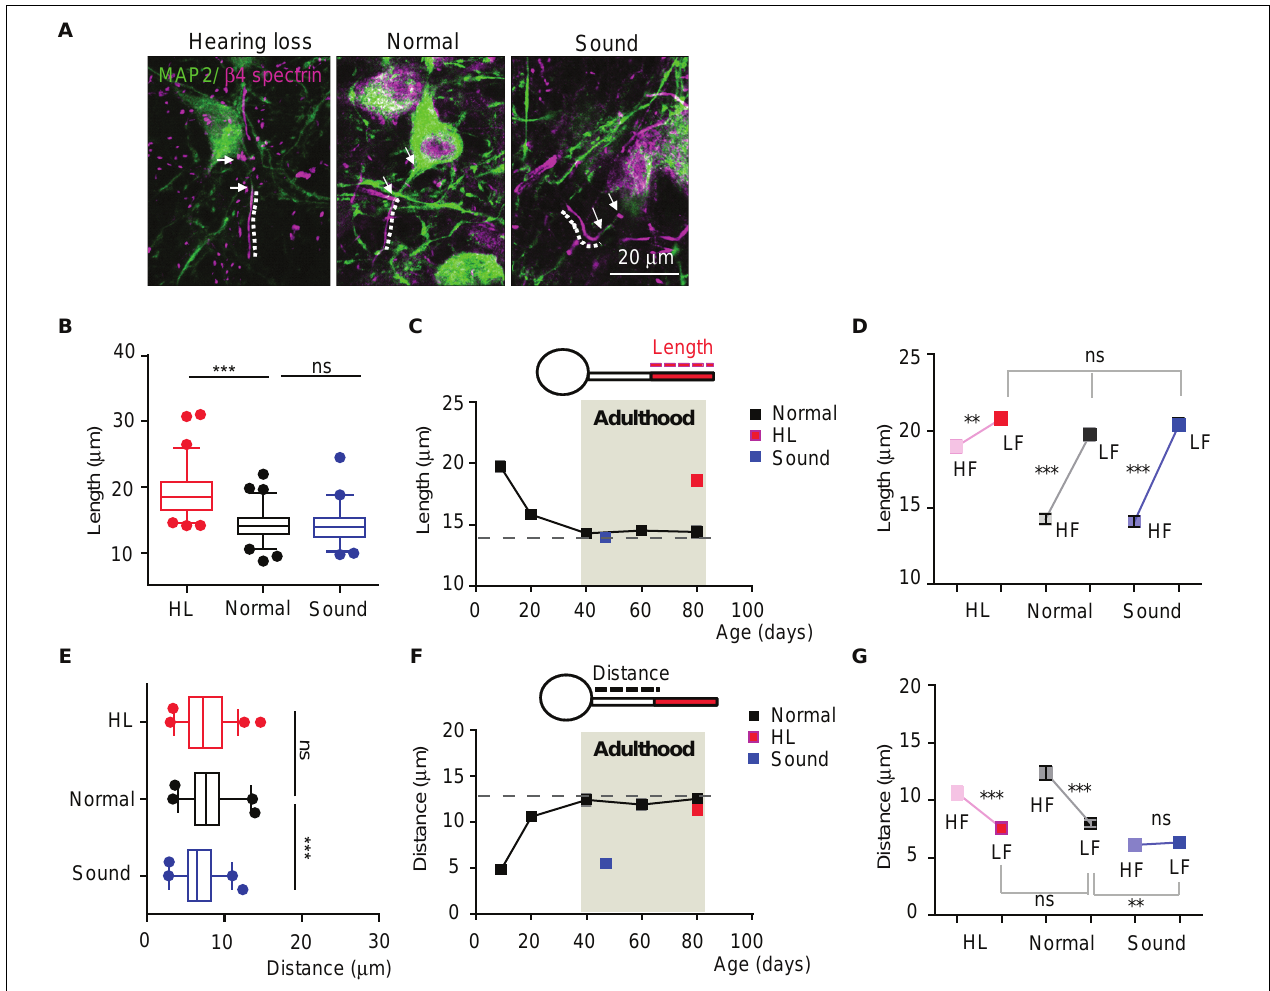
FIGURE 5 | Auditory experience regulates AIS structural and spatial plasticity in adulthood. (A) HF MNTB neurons, immunostained with MAP2 and β 4 spectrin from hearing loss (HL), Normal, and Sound. The dotted line and white arrow indicate AIS length and distance, respectively. (B) Summary of AIS lengths in HF neurons from HL, Normal, and Sound. ∗∗∗ p < 0.001, Kruskal–Wallis test with Dunn’s post hoc test. (C) The plot of AIS length in HF neurons from normal mice from P9 to P80 (black, shown in Figure 3D ), and those from HL (at P80, red), and Sound (at P45, blue). (D) Tonotopy of AIS length between HF and LF neurons from HL, Normal, and Sound groups. ∗∗ p < 0.01, ∗∗∗ p < 0.0001, Mann–Whitney U test for HF and LF neurons; ns, non-significant, Kruskal–Wallis with Dunn’s post hoc test for AIS length of LF neurons from HL, Normal, Sound. (E) Summary of AIS distance in HF neurons from HL (red), Normal (black), and Sound (blue). ∗∗∗ p < 0.0001, one-way ANOVA with Turkey’s multiple comparison test. (F) The plot of AIS distance in HF neurons from Normal from P9 to P80 (black, shown in Figure 3E ), and those from HL (red) and Sound (blue). (G) Tonotopy of AIS location between HF and LF neurons from HL, Normal, and Sound. ∗∗∗ p < 0.0001, unpaired t -test for HF and LF neurons; ∗∗ p < 0.01, one-way ANOVA with Turkey’s multiple comparison test for AIS distance of LF neurons from hearing loss, normal, sound group.